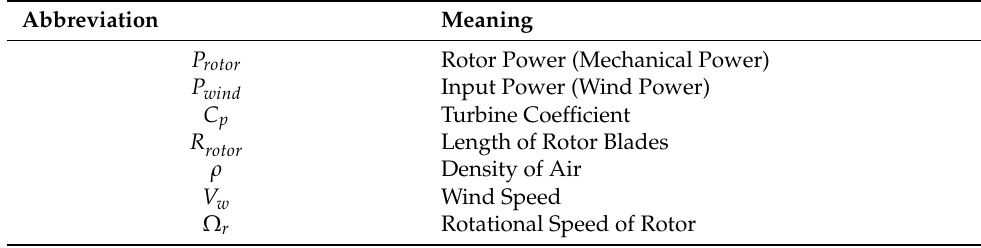
Table 6. Common abbreviations that do not need defining in the